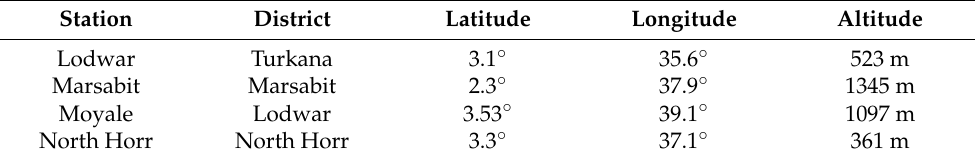
Table 1. Schematic summary of the land-based meteorological stations’ characteristics. Station